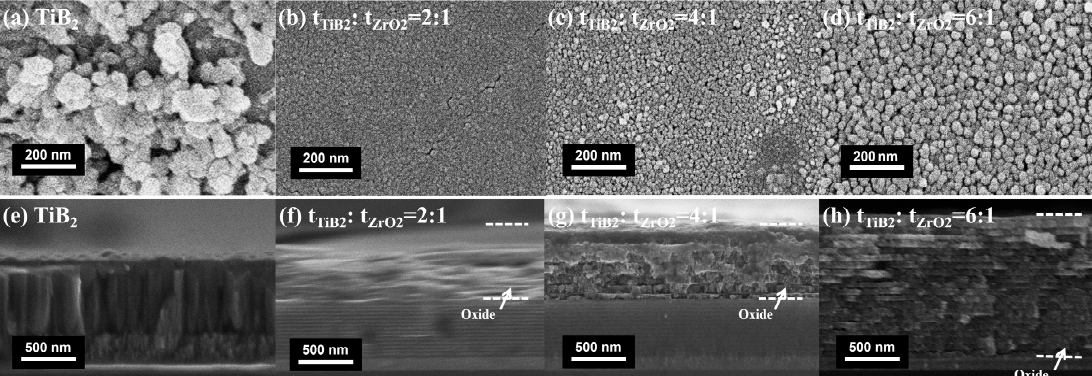
Figure 2. The surface and cross-sectional SEM images of the TiB 2 monolayers ( a , e ), and TiB 2 /ZrO 2 multilayers with t TiB ₂ : t ZrO ₂ = 2:1 ( b , f ), t TiB ₂ : t ZrO ₂ = 4:1 ( c , g ) and t TiB ₂ : t ZrO ₂ = 6:1 ( d , h ) after annealing in air at 600 °C for 1 h.